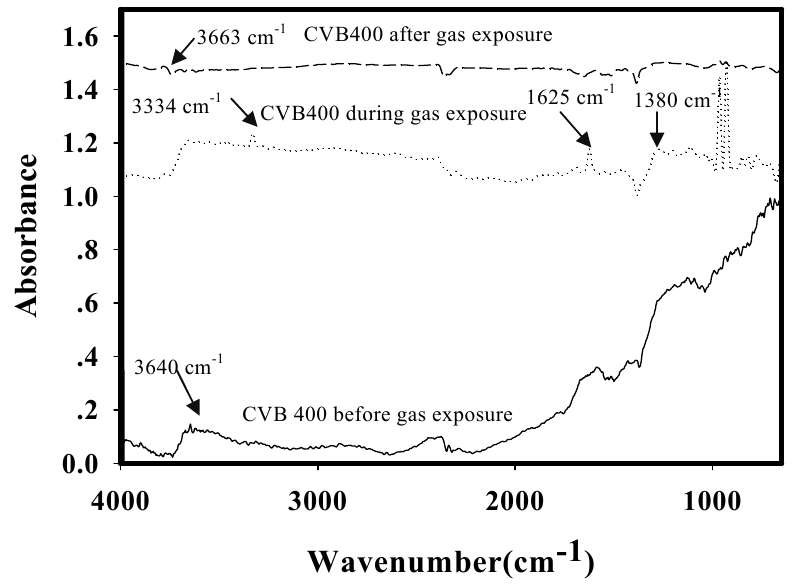
Figure 4. IR spectra of the zeolite Y (Si/Al = 5.1, H + ) exposed to NH pressure at 1 atm, and at T = 25 ºC).